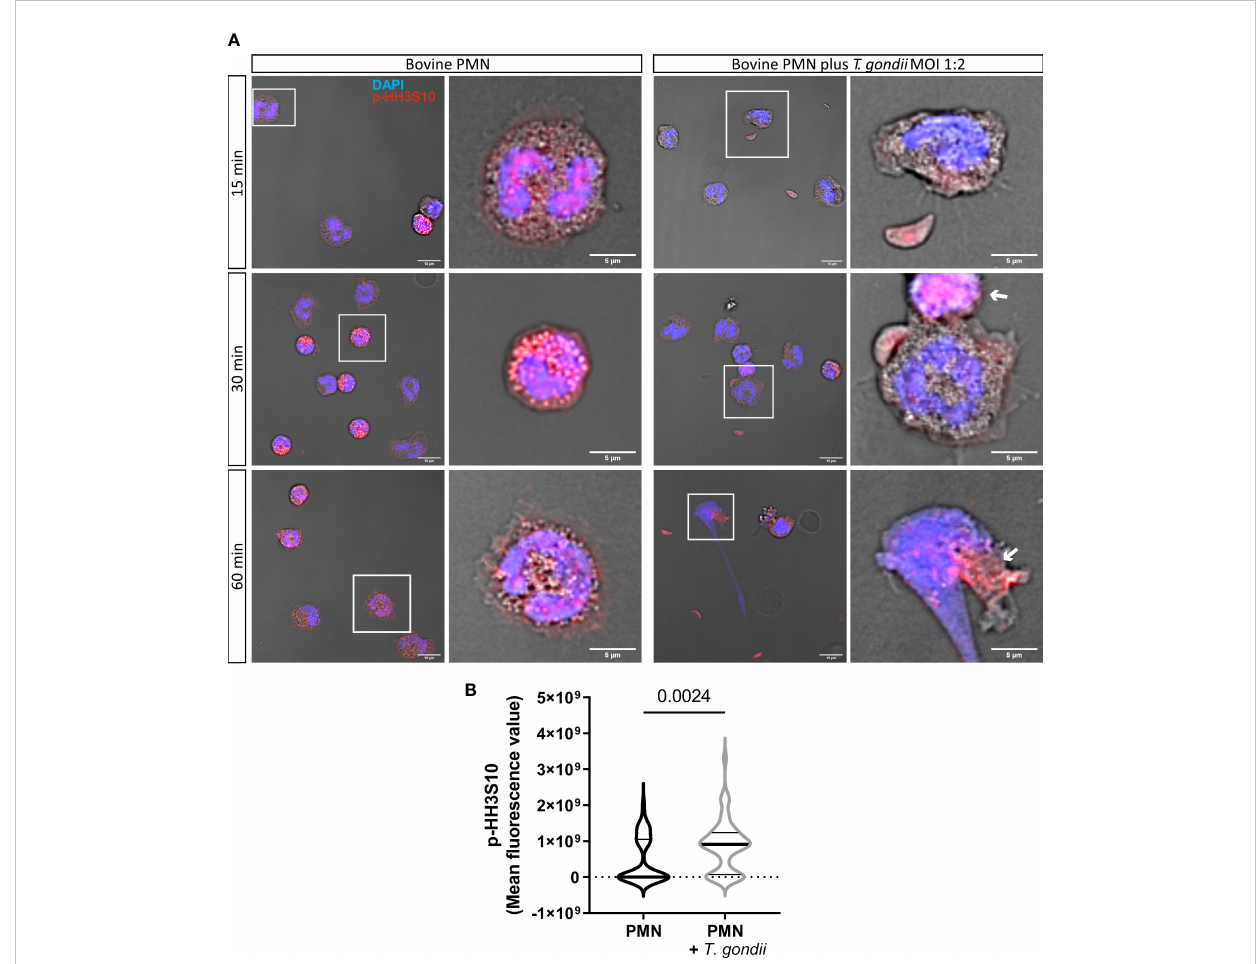
FIGURE 4 T. gondii induces upregulation of the mitotic marker p-HH3S10 in exposed bovine PMN. 2 × 10 5 bovine PMN were confronted with vital 4 × 10 5 T. gondii tachyzoites (1:2 ratio) for 60 min. Samples were fi xed in PFA 4% at 15, 30 and 60 min of interaction and the specimens were stained for the mitotic marker p-HH3S10 (red channel) and DNA (blue channel; DAPI). In white squares the cells which are zoomed in the corresponding right panel are shown (A) . The abundance of p-HH3S10 was determined at 60 min based on fl uorescence signals detected by confocal microscopy and represented as violin plot (line at mean). Differences in the expression of p-HH3S10 at 60 min of interaction were analysed by a Mann-Whitney test ( a = 0.05) (B) . White arrows indicate PMN with higher and relocated abundance of